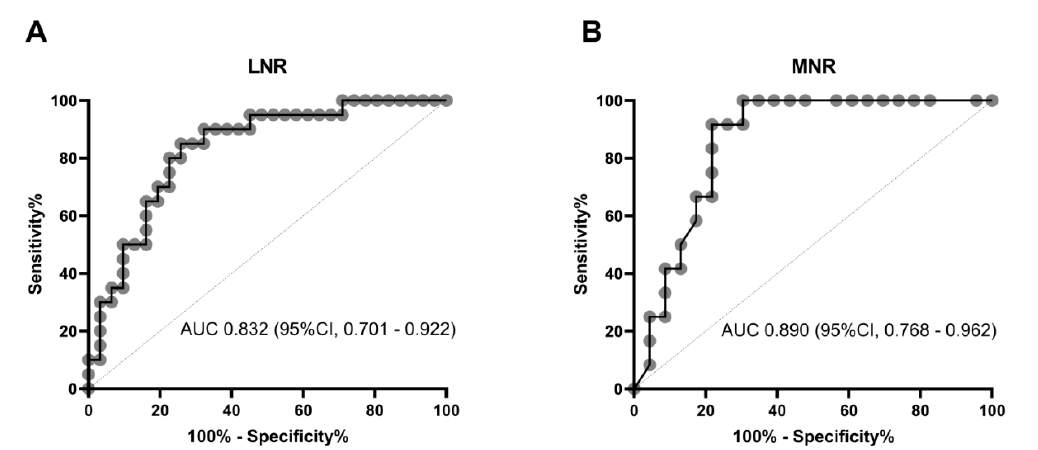
Figure 3. ROC curves for LNR and MNR to predict in-hospital mortality at admission in patients with severe Covid-19. ( A ) For LNR, the best cut-off point to predict in-hospital death was ≤ 0.088 with AUC of 0.832 (95% CI, 0.701–0.922), sensitivity of 85.00%, specificity of 74.19%, Youden index of 0.5919 (95%